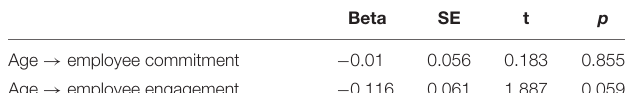
TABLE 3 | Total effect.